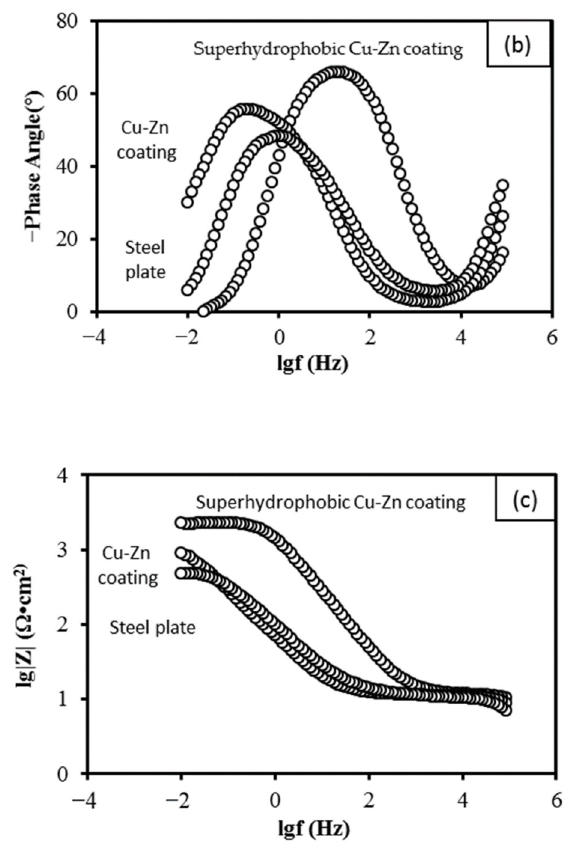
Figure 14. ( a ) the Nyquist plot ( b , c ) Bode plot of mild steel plate, untreated Cu-Zn coating, and annealed superhydrophobic Cu-Zn coating.